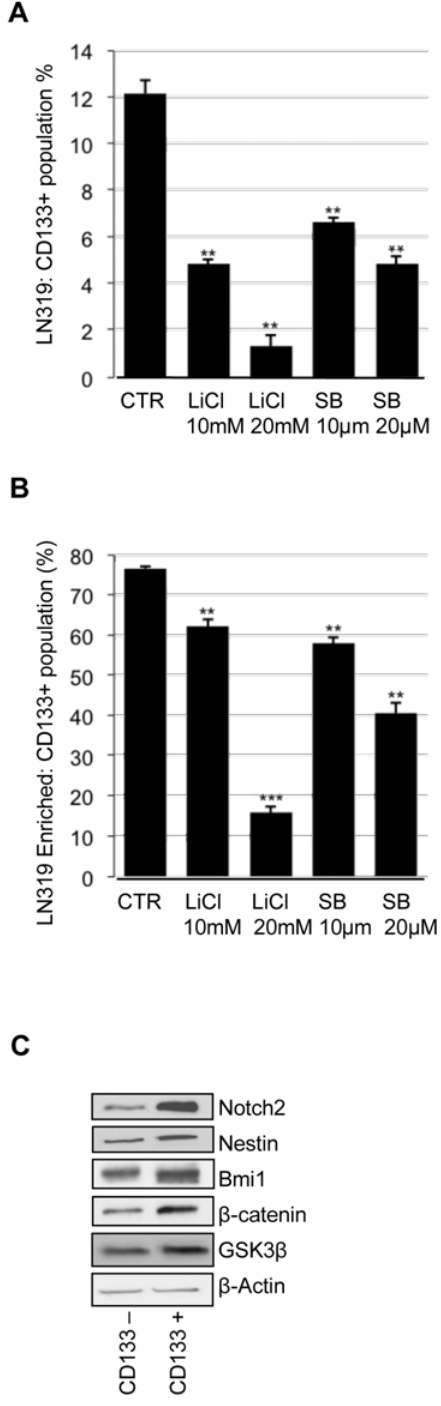
Figure 5. GSK3 b inhibition reduced the CD133 + cell population of a GBM cell line. (A) LN319 GBM cell line was treated for 72 h with 10 or 20 mM LiCl or with SB216763 at 10 or 20 m M. GSK3 b inhibition reduced the CD133-positive (CD133 + ) population. (B) LN319 CD133 + cells were enrichedto 80%purity by cell sorting.Theenrichedpopulation was treated for 72 h with 10 or 20 mM LiCl or with SB216763 at 10 or 20 m M. (C) Western blot analysis of Notch2, Nestin, Bmi1, b -catenin, GSK3 b and b -actin in CD133 + and CD133-negative (CD133-) enriched populations compared with the control. ** P , 0.01; *** P , 0.001; one-way ANOVA (Newman-Keuls Multiple Comparison